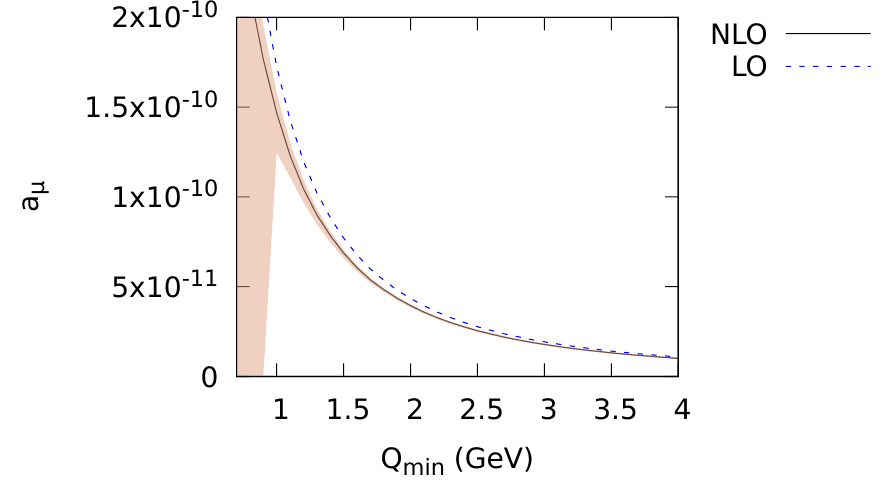
Figure 4 . Numerical results for the hadronic HLbL ( g − 2) µ in the Q i > Q min region, using the LO (massless quark loop) and NLO (gluonic corrections) contributions of its corresponding OPE. Uncertainties, apart from the one coming from the α s ( M W ) input, represented by shaded areas have being estimated attending to ambiguities when setting the α s input (exact choice of scale and order of running for the β function) as a consequence of not including